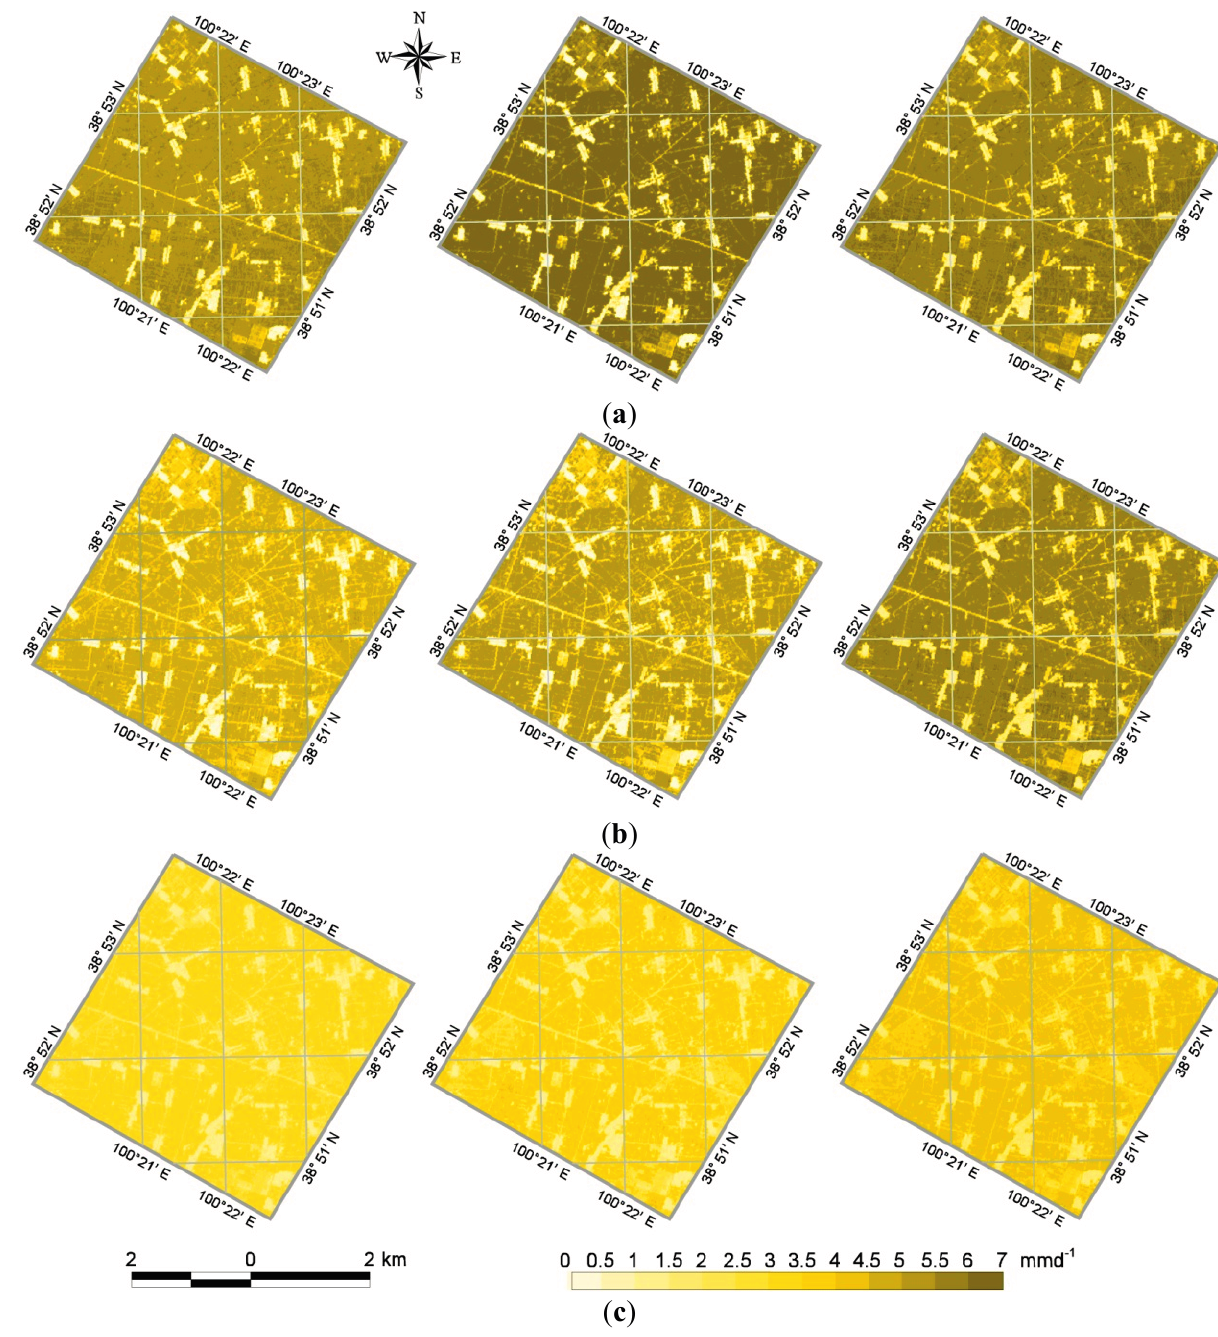
Figure 6. Maps of the total daytime ET (from 9:00 to 19:00) on ( a ) 10th July, ( b ) 2nd August and ( c ) 11th August of 2012 integrated using the cEF (left), vEF (middle) and vEFr (right)